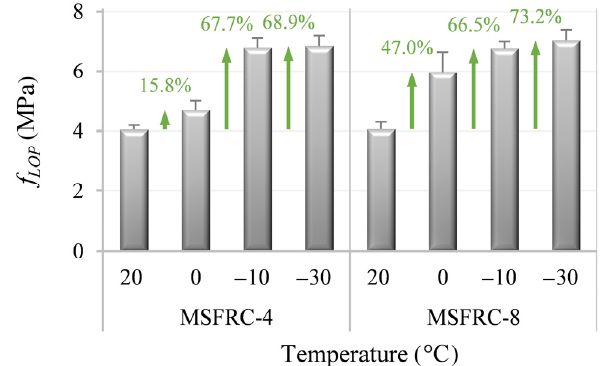
Figure 4. Mean values of f LOP with corresponding standard deviations of the studied MSFRCs at different temperatures.